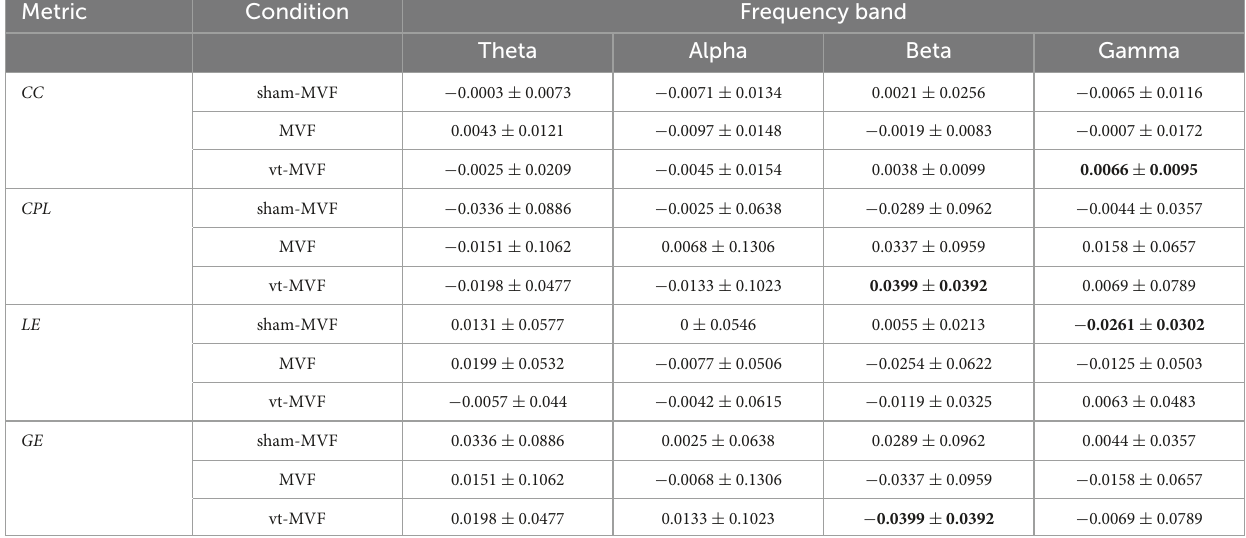
TABLE 2 Laterality index (mean ± standard deviation) of the sham-MVF, MVF, and vt-MVF experimental conditions in different frequency bands.